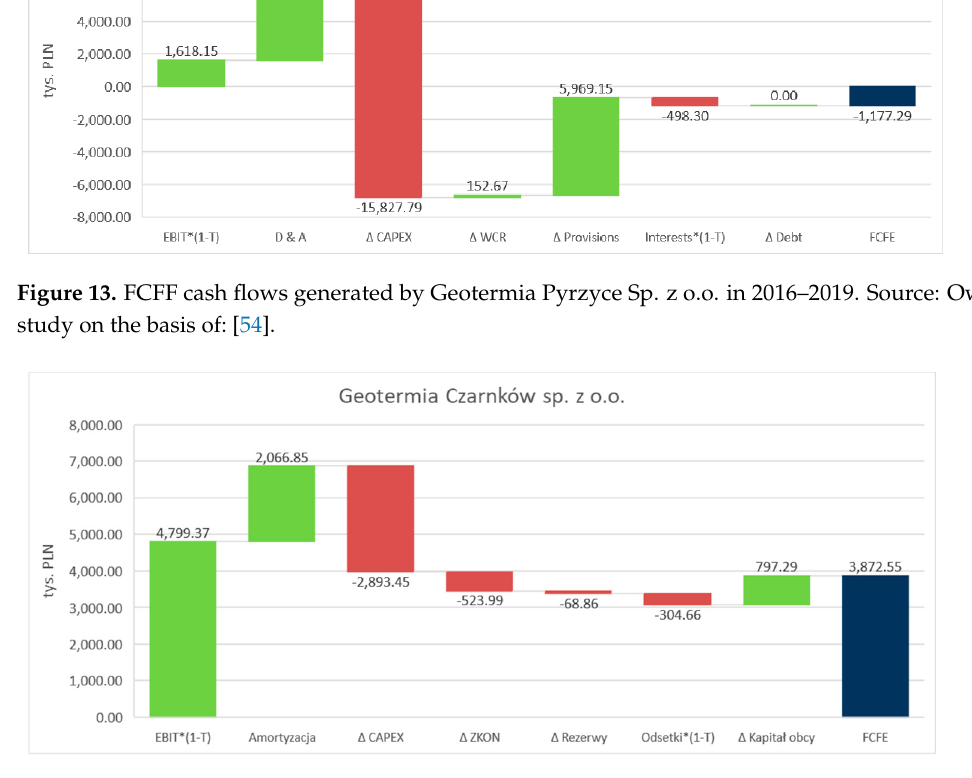
Figure 14. FCFF cash flows generated by Geotermia Czarnków Sp. z o.o. in 2016–2019. Source: Own study on the basis of: [55].